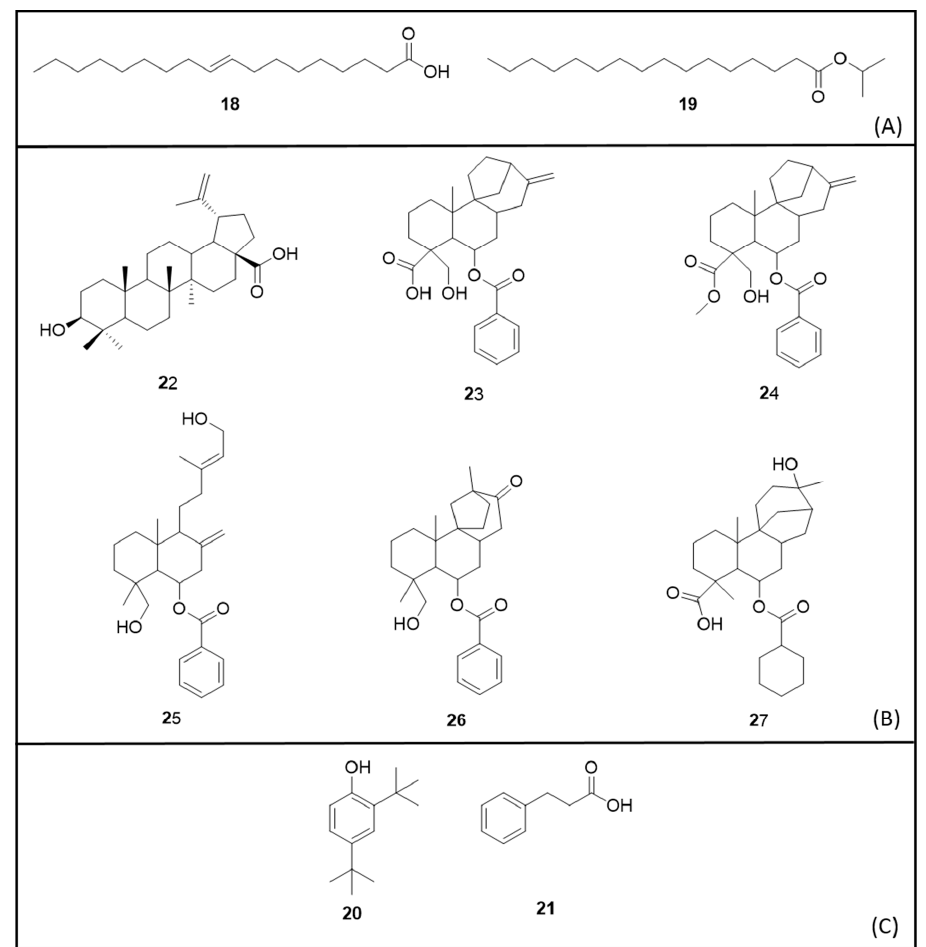
Figure 4. Secondary metabolites identified in organic extracts with insecticidal activity against Ae. aegypti . ( A ) Fatty acid and derivatives, ( B ) Diterpenes and triterpenes and ( C ) Others.